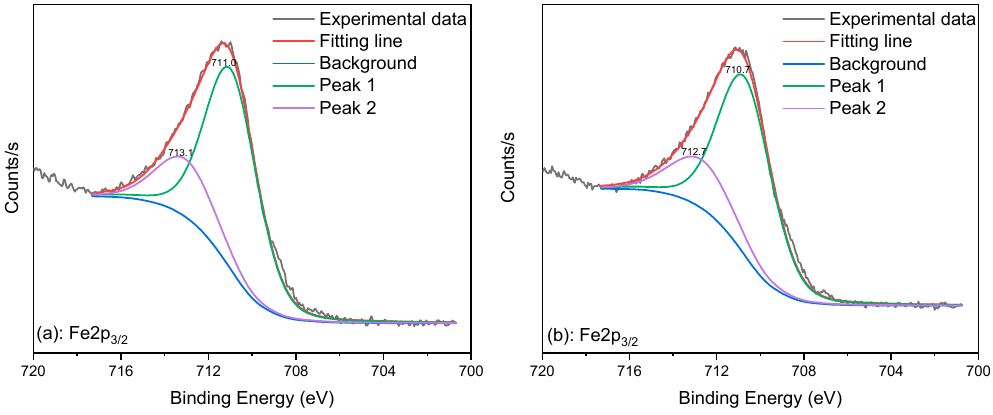
Figure 8. High resolution spectra of Fe2p3/2: ( a ) pure ilmenite; ( b ) pure ilmenite+BS-12.